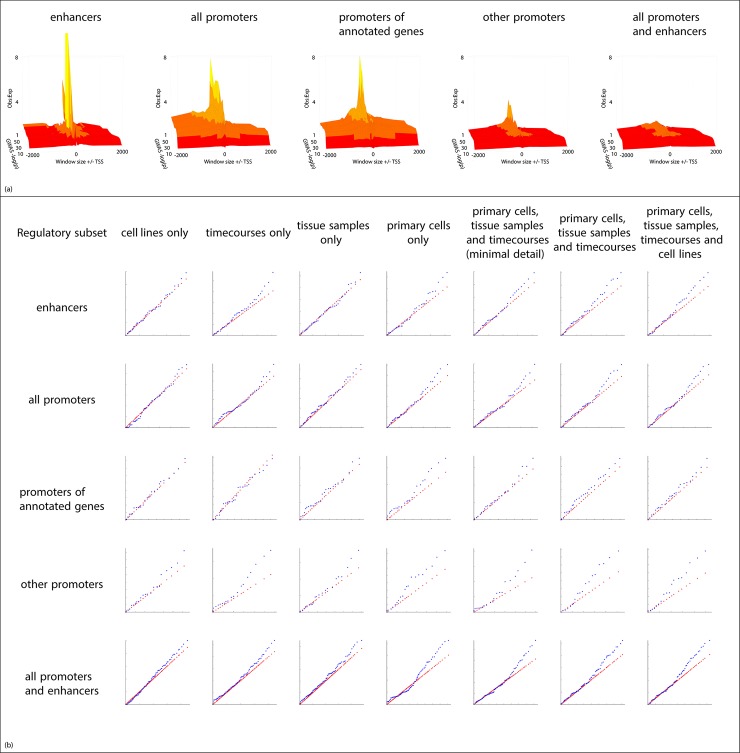
(a) Enrichment (y axis, observed SNPs per Mb: expected SNPs per Mb) at increasing search window sizes (x axis) upstream and downstream from the transcription start site (TSS) for increasingly strong GWAS signals (z axis, −log10p). (b) Change in coexpression signal using different subsets of the FANTOM5 dataset, using the Crohn’s disease GWAS as the input set. Q:Q plots of observed:expected NDA scores obtained using a given subset of samples (see methods for full description of each subset). Rows indicate the subset of regulatory regions used in each analysis. Percentage of significantly coexpressed entities (hits, FDR < 0.05) and p-value (Kolmogorov-Smirnov test) comparing observed (blue) and expected (red) distributions are shown below each plot.